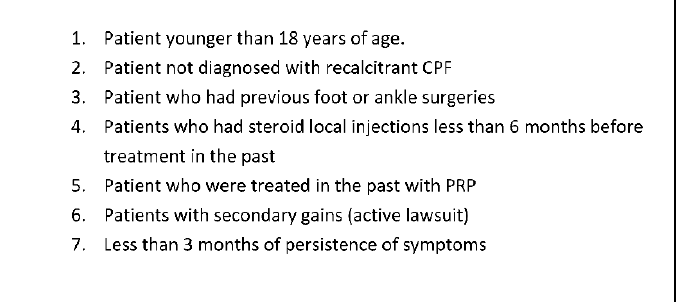
Figure 2. Exclusion criteria. CPF: chronic plantar fasciitis.